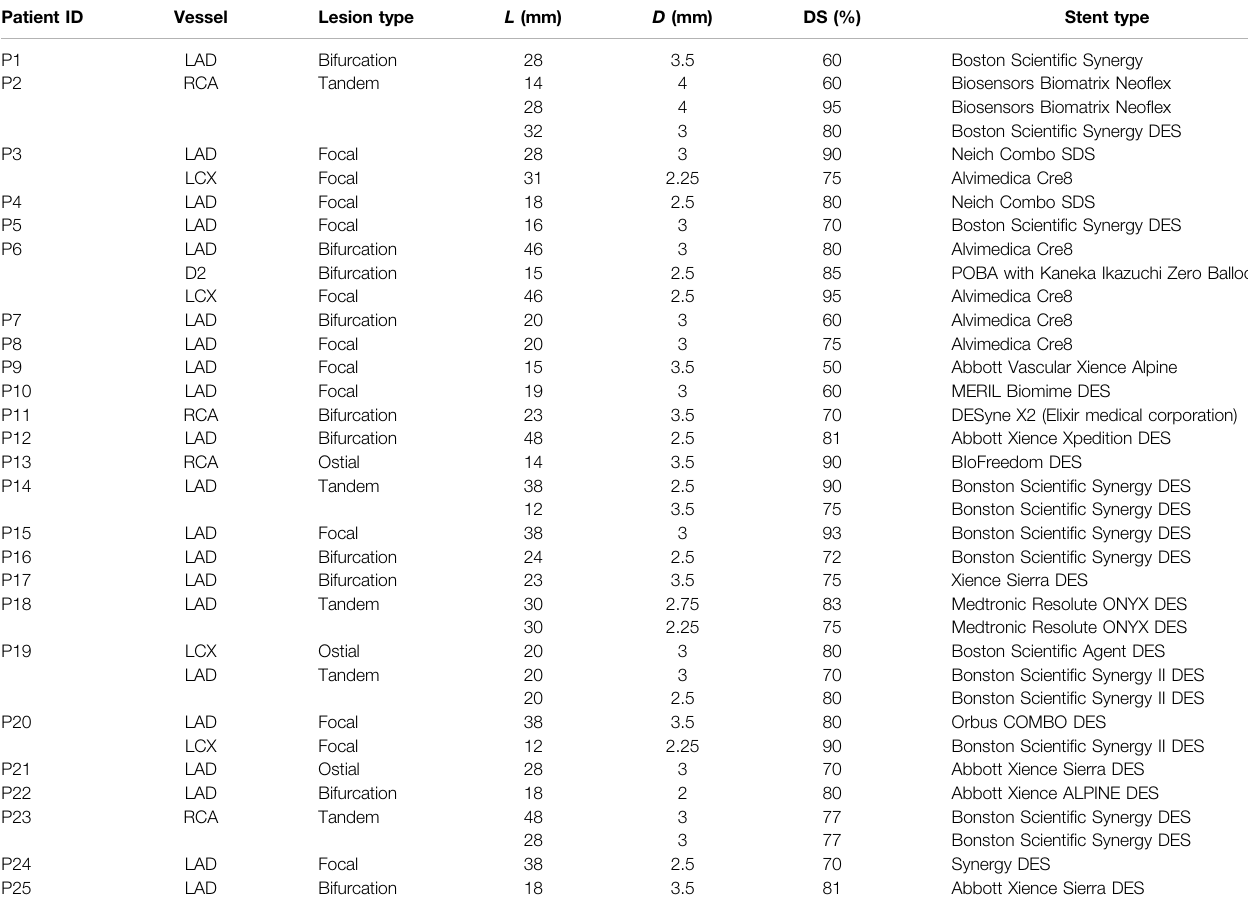
TABLE 2 | Baseline lesion and implanted stent characteristics. Patient